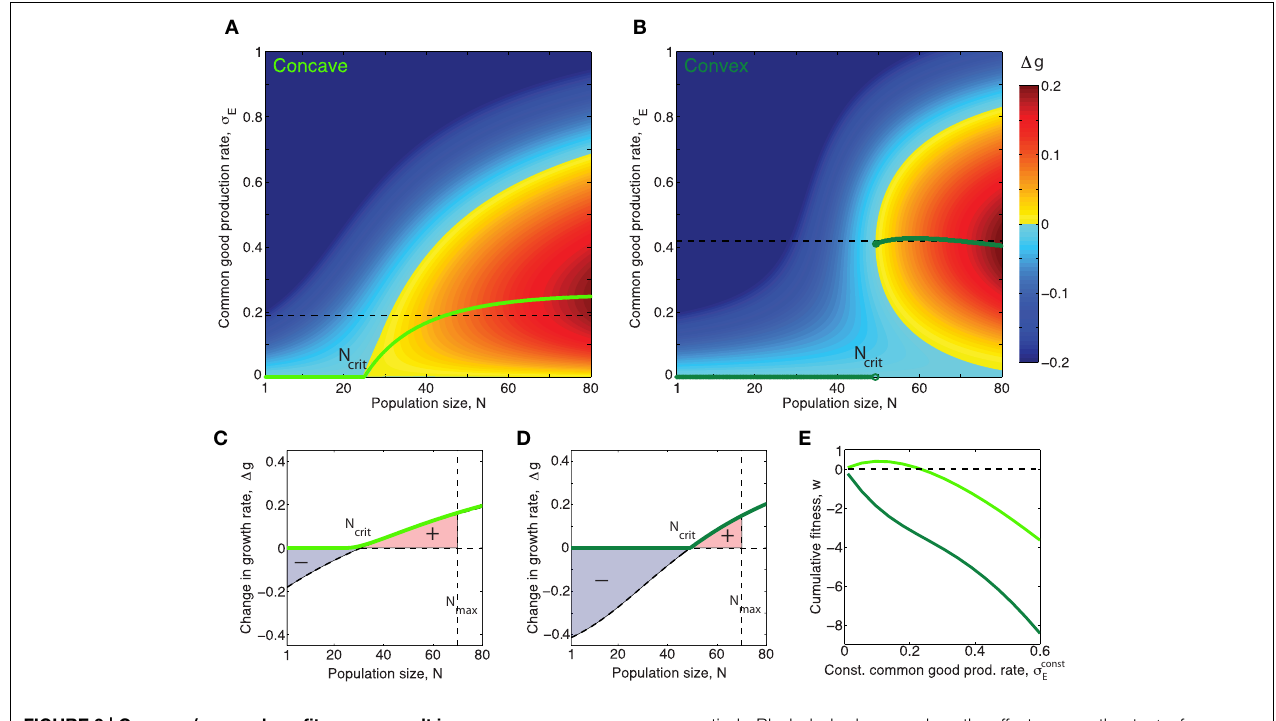
respectively. Black dashed curves show the effect on growth rate 1 g for a population producing common good at a constant rate σ const E = 1 / ( N max − N crit ) 6 Nmax Ncrit σ opt E ( N ) , equal to the average of the non-zero part of the optimal curve, (shown as black dashed lines in (A,B) . (E) Nmax The cumulative fitness, w ≡ ( 1 1 g ( N ) dN ) / w max , where Nmax R opt ( N ) dN , (def. in Equation 7) of different constant w max ≡ 1 1 g R production strategies for a common good with concave (light green) and convex (dark green) benefit functions respectively. Note that in the case of the “concave common good” there is a range of different constant production rates which allows the population to perform better than a nonproducing population w > 0 , however for the “convex common good” any constant production strategy will leed to worse fitness than that of a nonproducing population, w < 0 for all σ const E > 0 . (In this figure σ E is given in units of κ/γ E , which was set to